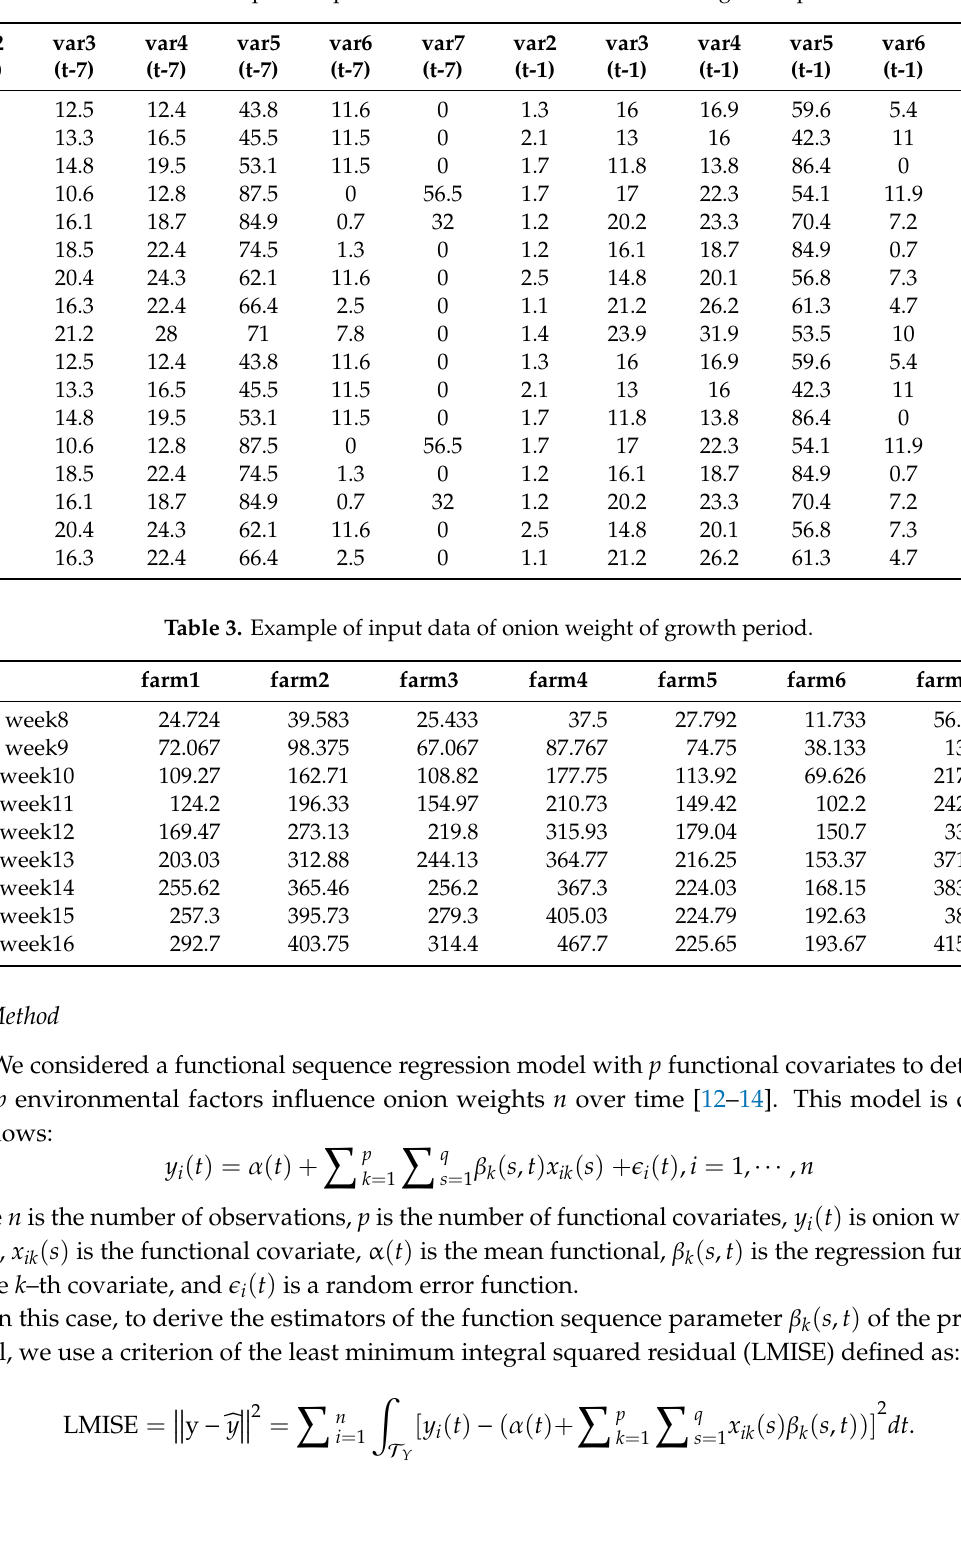
Table 2. Example of input data of environmental variables of growth period.